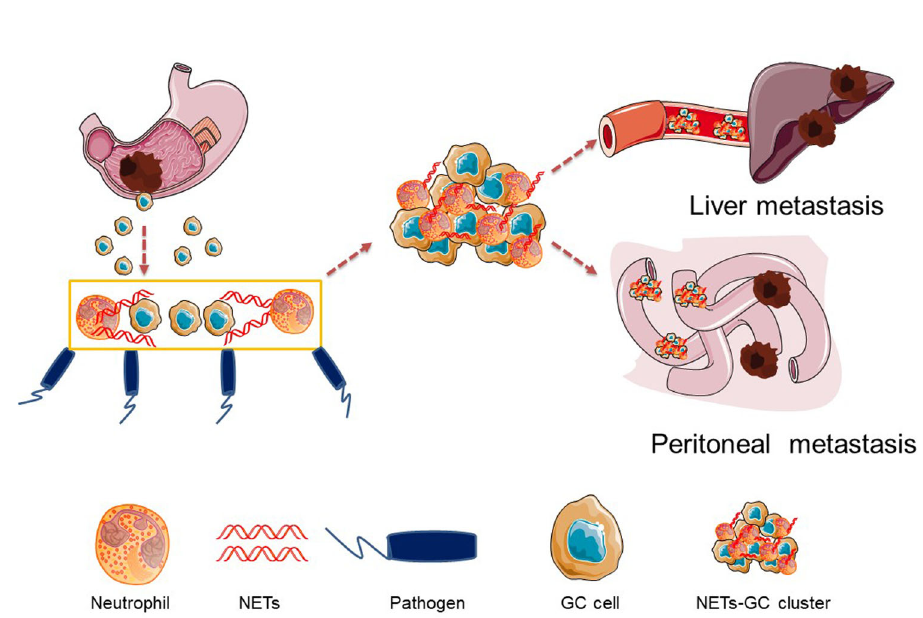
Fig. 7 Proposed mechanism for the metastatic tropism of NETs-GC clusters due to postoperative AIC. Free GC cells from primary GC could develop into CGCs (circulating GC cells) in peripheral blood or DGCs (disseminated GC cells) in abdominal cavity. Once postoperative AIC occur after surgery, pathogens or in fl ammatory factors would stimulate neutrophils to release NETs not only in peripheral blood but also at infectious sites (abdominal cavity), then in which those NETs trap CGCs or DGCs to form NETs-GC clusters, that potentially facilitate GC cells